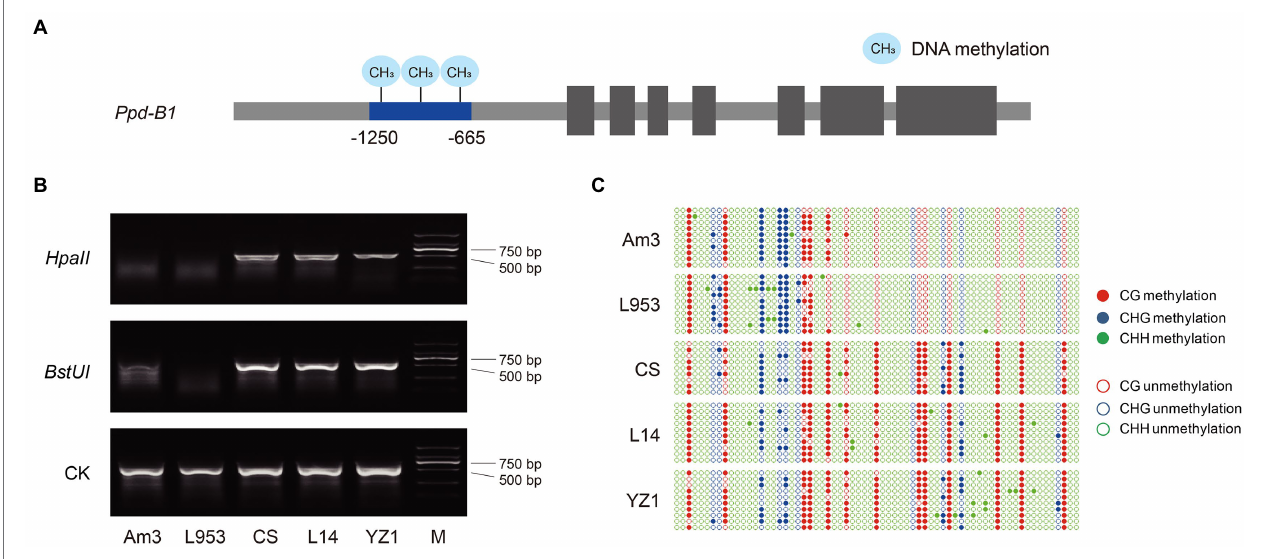
FIGURE 1 | Development and verification of Ppd-B1 methylation molecular markers. (A) Ppd-B1 differential methylation region ( − 1,250 to − 665), which contains the methylation-sensitive restriction endonuclease (MSRE) Hpa II or BstU I recognition sites (CCGG or CGCG), was selected to design markers. (B) A MSRE marker was used to identify wheat accessions with different methylation levels. Undigested DNA is shown as a control. (C) Materials with different Ppd-B1 methylation levels were identified by the bisulfite genomic sequencing method. The solid and hollow circles represent methylated and unmethylated cytosine residues, respectively. Red, blue, and green circles represent CG, CHG, and CHH contexts, respectively. Data shown are representative of the results of three independent biological replicates. The accession abbreviations are L953, “Laizhou 953”; CS, “Chinese Spring”; L14, “Lumai 14”; and YZ1, “Yanzhan 1.”